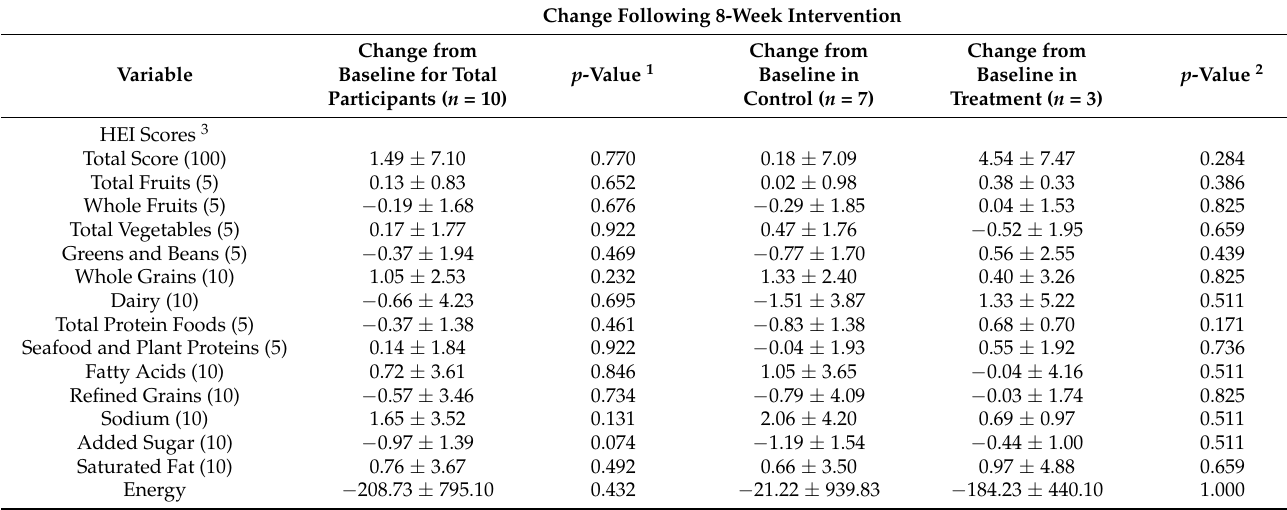
Table 2. Changes in dietary quality assessed by Healthy Eating Index scores between baseline and 8 weeks ( n = 10).